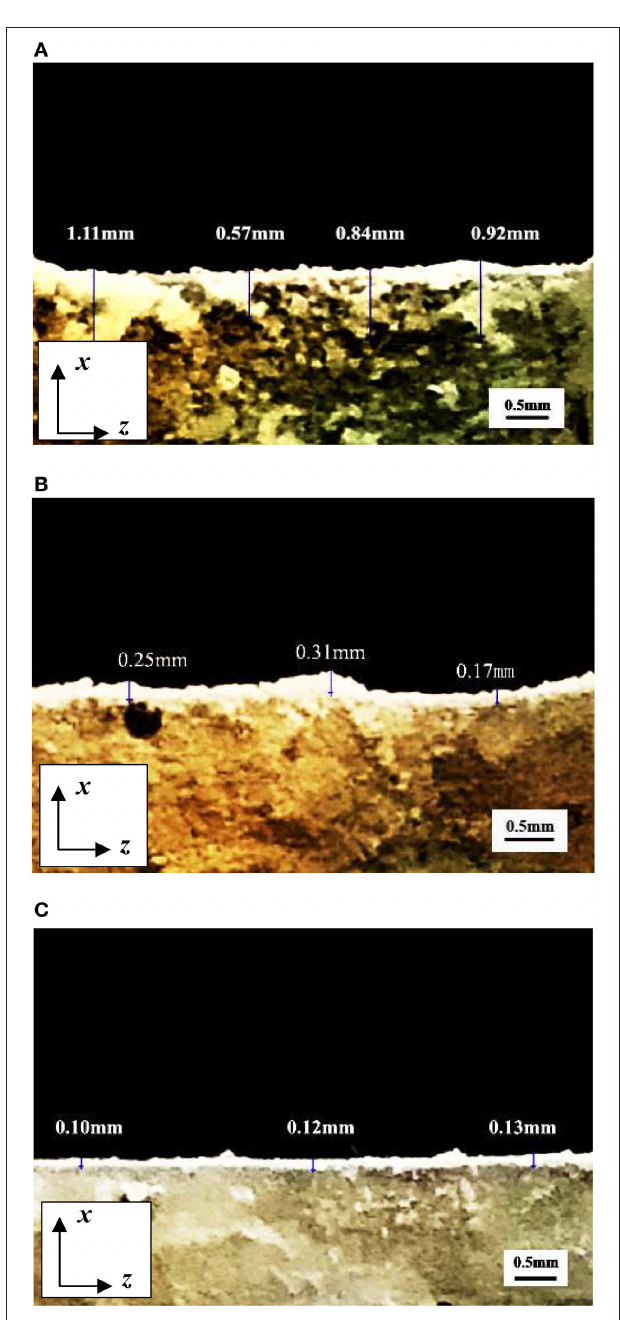
FIGURE 16 | The CaCO 3 precipitated in depth direction of fracture section under different crack width. (A) Crack width was 0.2mm; (B) Crack width was 0.6mm; (C) Crack width was 1.0mm.